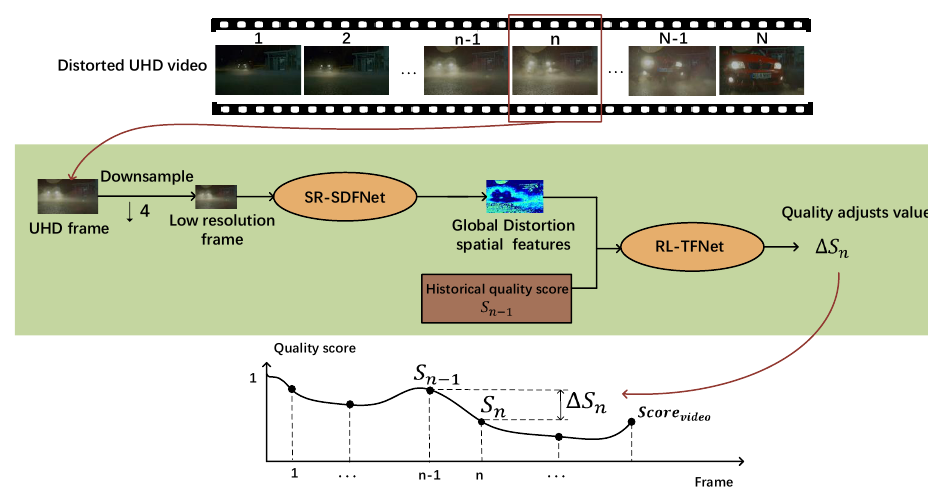
Figure 3. Processing pipeline of the proposed model BVQA − SR&DRL. The SR − SDFNet model is used to extract spatial distortion features from the UHD video frame. Then, the RL-TFNet model observes the spatial features and the historical quality score S n − 1 , which outputs ∆ S n to adjust the quality score. The prediction process of the entire video score is shown in the line